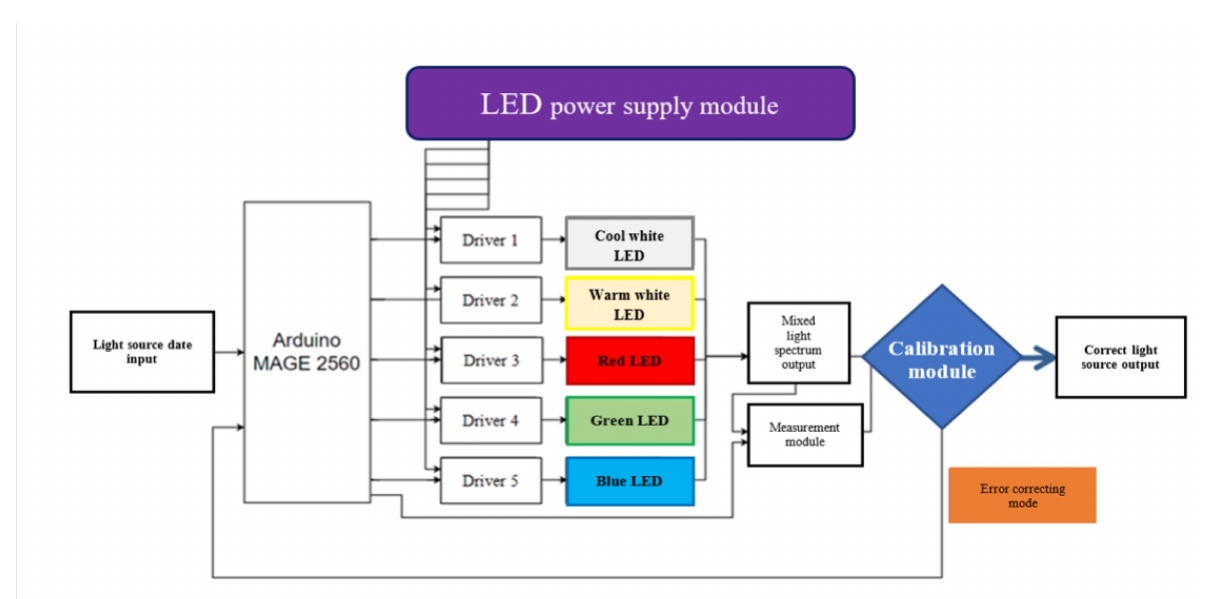
Figure 1. Flow chart of novel hypnotic lighting system control and correction. This technology consists of RGB LEDs and two cool and warm white LEDs to form a multi-spectrum dynamic light supply system. It has a measurement and correction system that can monitor and control the spectrum, illuminance, CCT, color rendering and Duv.(driver: led power driver, led drive power supply; cool white LED CCT: 6000 K ± 100 K. warm white LED CCT: 3300 K ± 100 K).